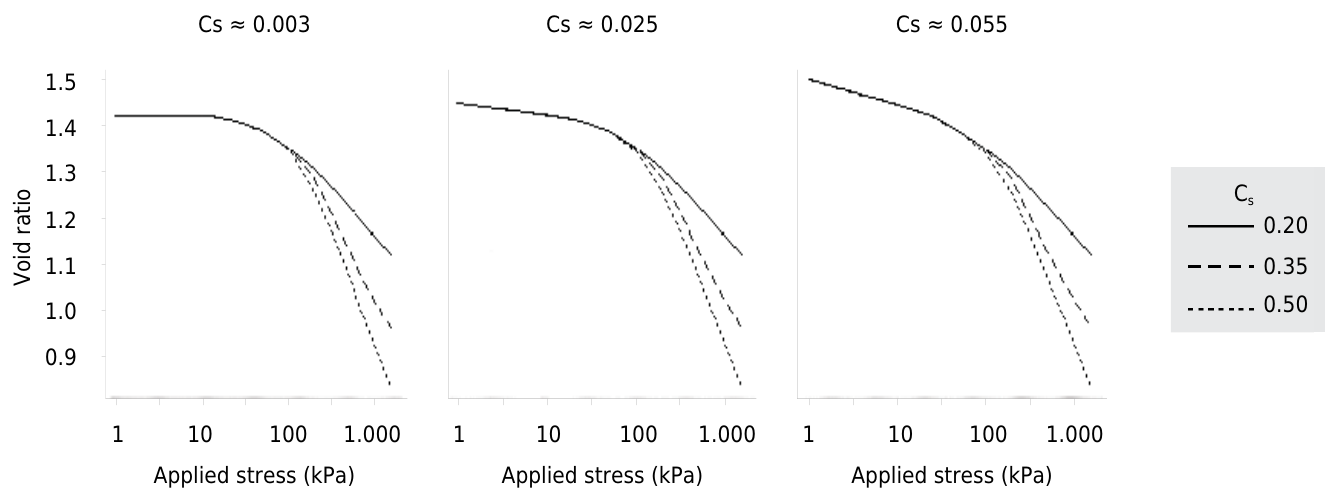
Figure 2. Simulation scenarios, created by combining three values of the compressibility coefficient (C c ) and three values of the swelling index (C s